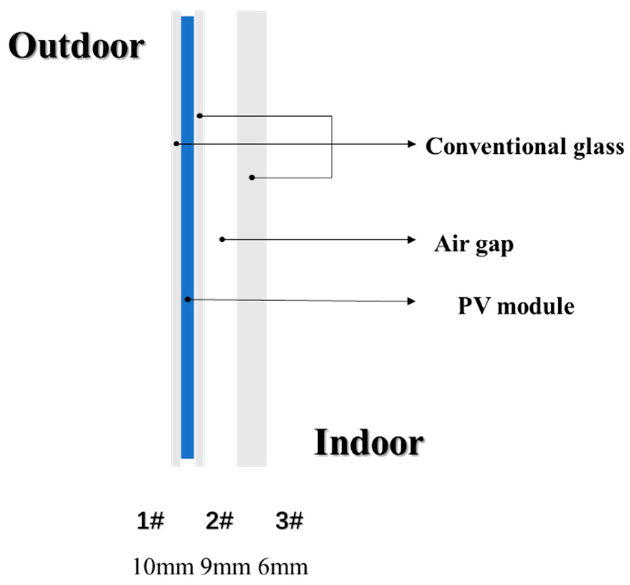
Figure 2. Schematic diagram of double-skin STPV window.